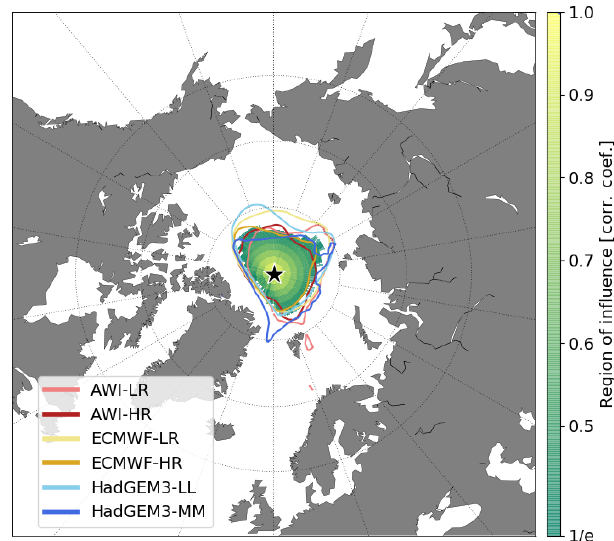
Figure 3. Region of influence for a station arbitrarily placed at the North Pole (black star) as defined by each model (colourful lines) and by the averaged region of influence from the different models (shades of green to